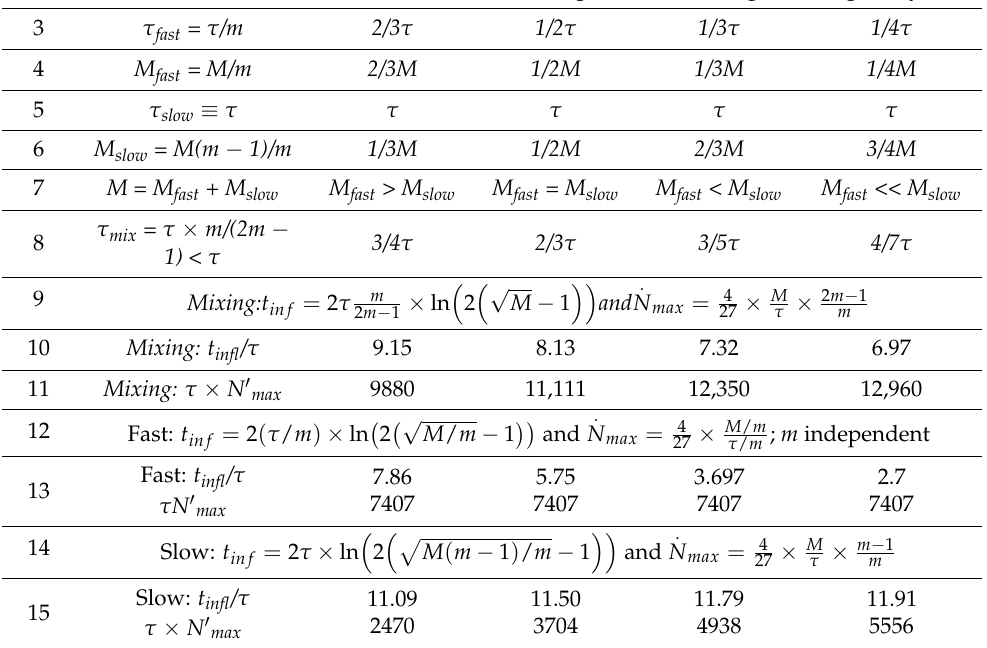
Table A1. Cont . Nº From Almost Homogeneous to Strong